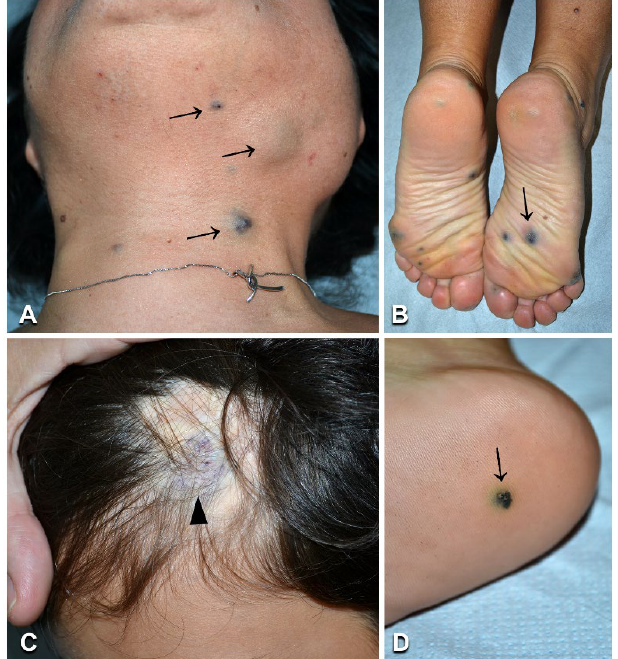
Figure 8. Clinical features of blue rubber bleb nevus syndrome: A woman aged 42 years (Table 1, n. 40) presents multiple cutaneous and subcutaneous bluish papules and nodules, including on plantar surfaces (arrows in A , B ). A similar lesion is visible in a 9-year-old boy (Table 1, n. 41) ( D , arrow), together with the characteristic violaceous congenital plaque on the left occipital area ( C , arrowhead).